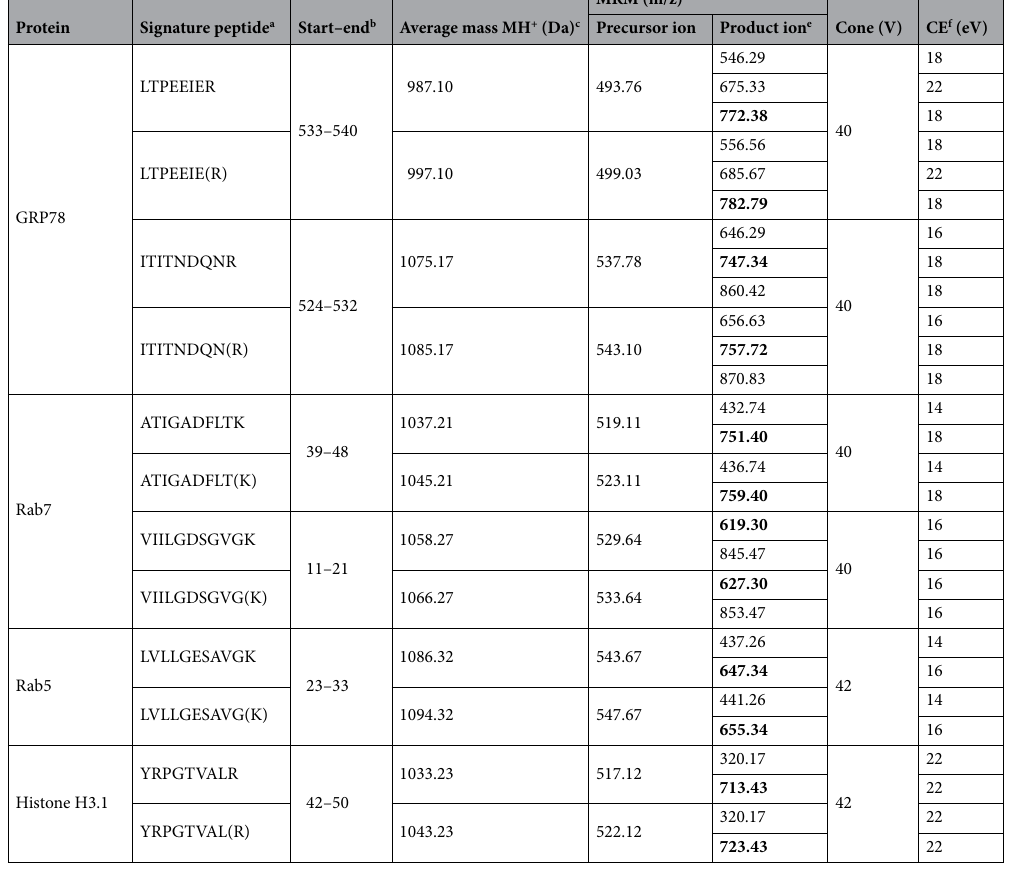
Table 1. Signature peptides for organelle markers and three case study proteins and their corresponding MRM methods. a Stable isotope-labeled amino acid residues are included in parentheses. b Start and end residue positions of peptides in the corresponding full-length protein. c Theoretical average mass of mono-protonated molecular ion. d All precursor ions have a charge state of + 2, and all product ions used as the quantification trace have a charge state of + 1. e Bolded product ions were used as the quantification trace during MRM. f CE = Collision Energy.